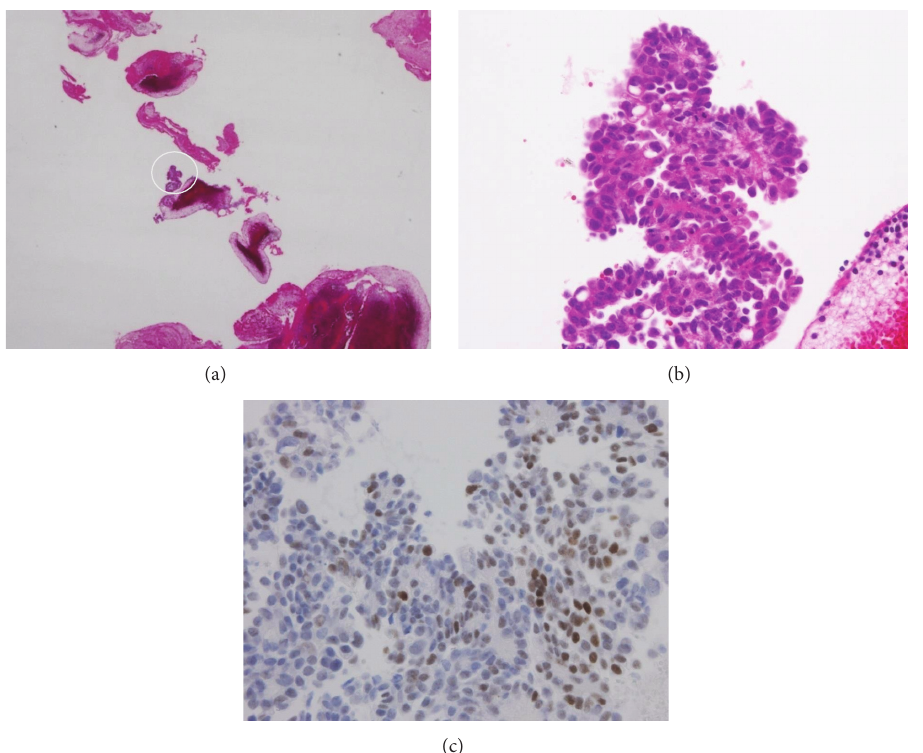
Figure 3: Histology of tumor cells in the blood clot (a)–(c). Tumor cells are seen in the blood clot (hematoxylin and eosin stain, × 100 (a)). Atypical cells with eosinophilic cytoplasm showing a high N/C ratio proliferating in a papillary pattern (hematoxylin and eosin stain, × 400 (b)). Note the positive (brownish) staining for estrogen receptors (Immunostaining for estrogen receptors